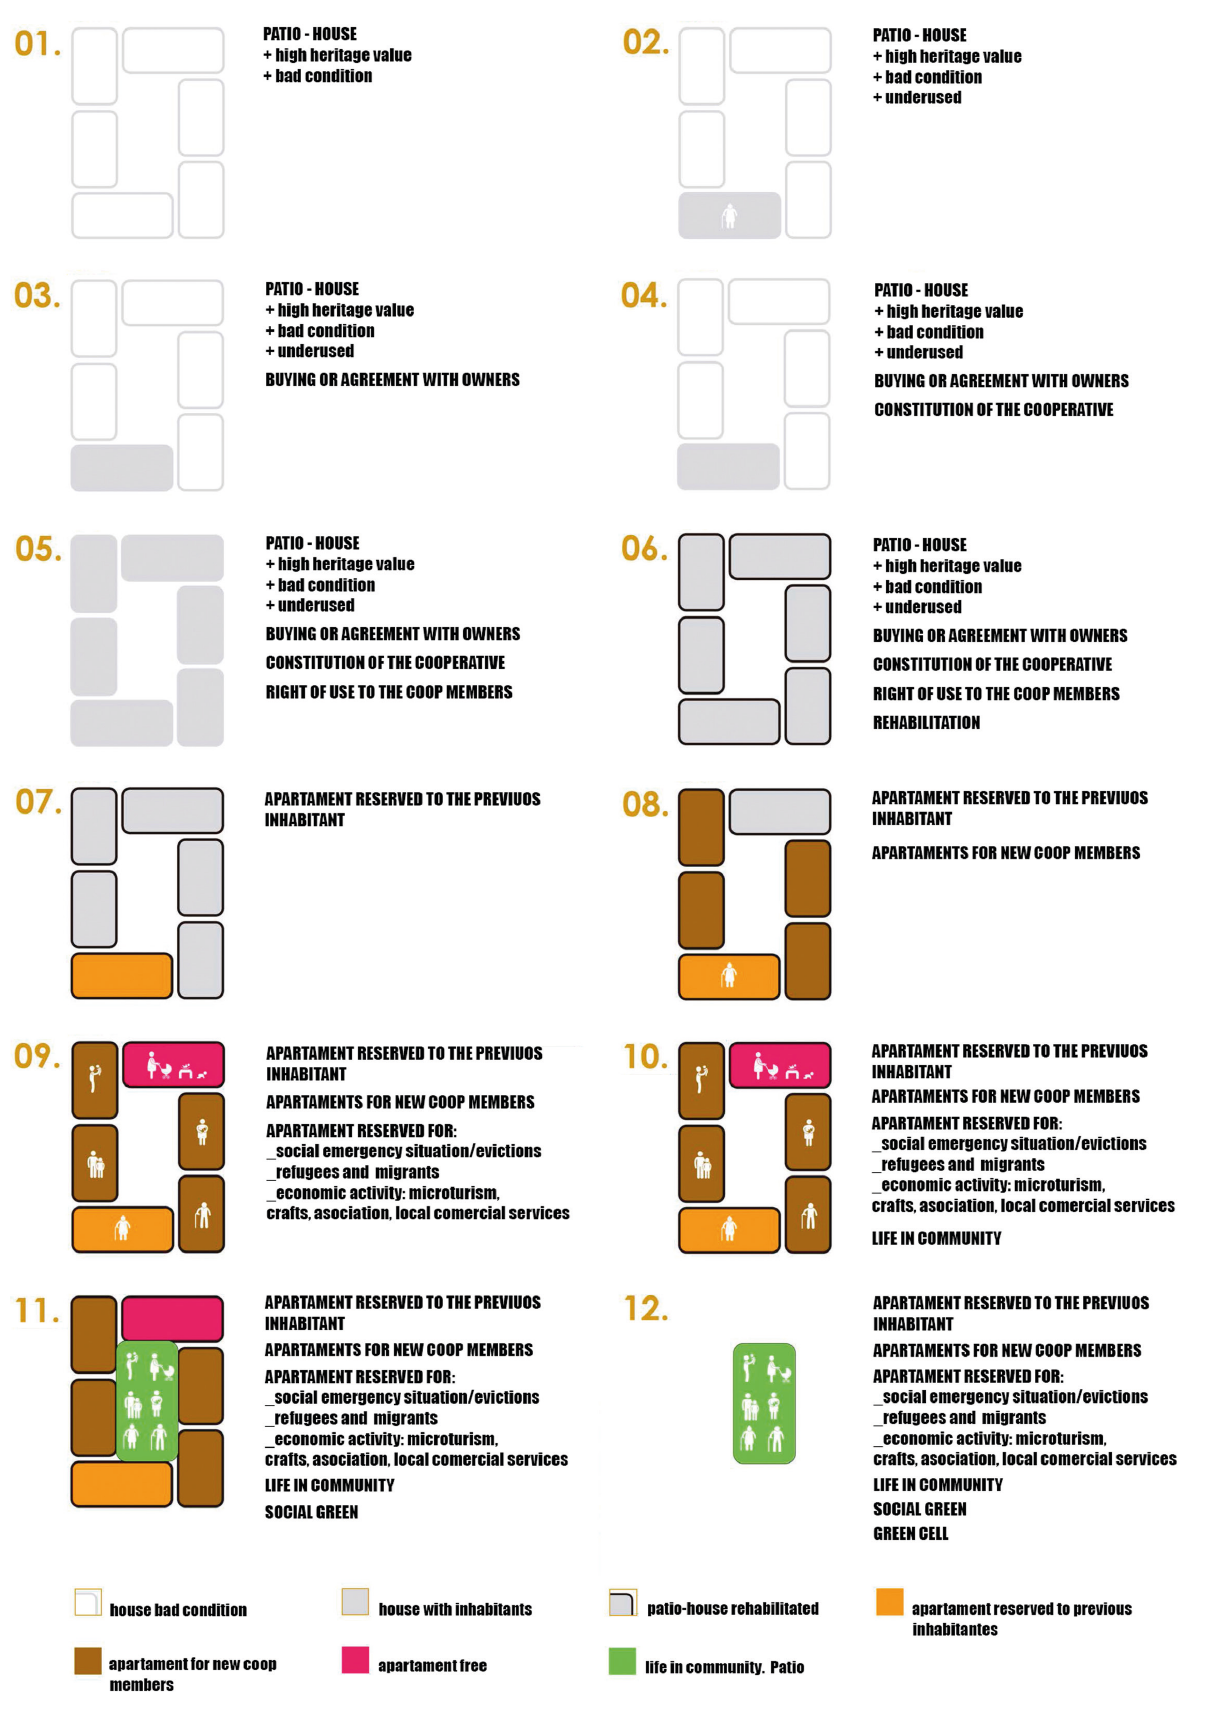
Figure 5 A scheme with the sequence of a Patio House Activation proposed by PAX (Source: